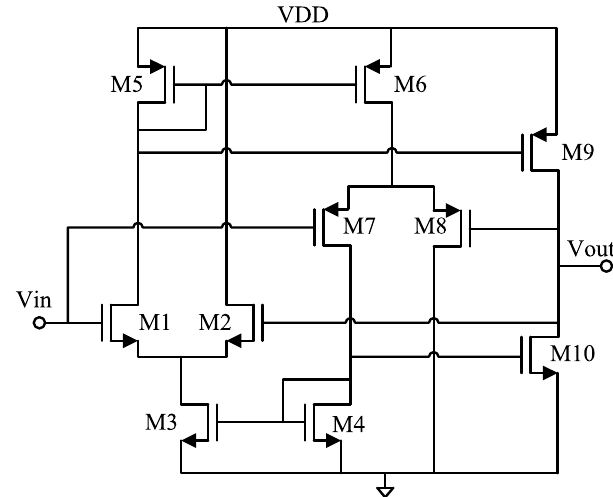
Figure 7. Circuit schematic of single-ended Class AB